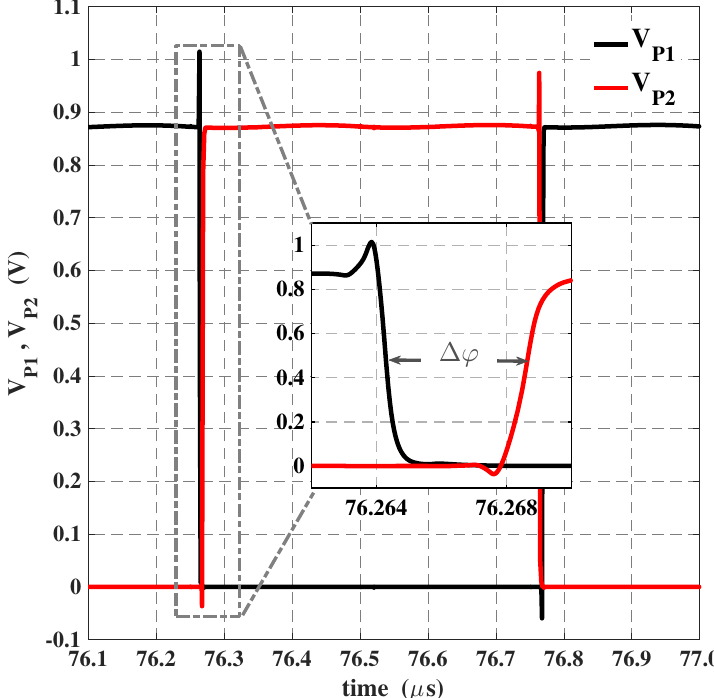
Figure 9. Transient simulation of the non-overlapping phase generator with zoom on the ∆ ϕ ∼ 4ns.